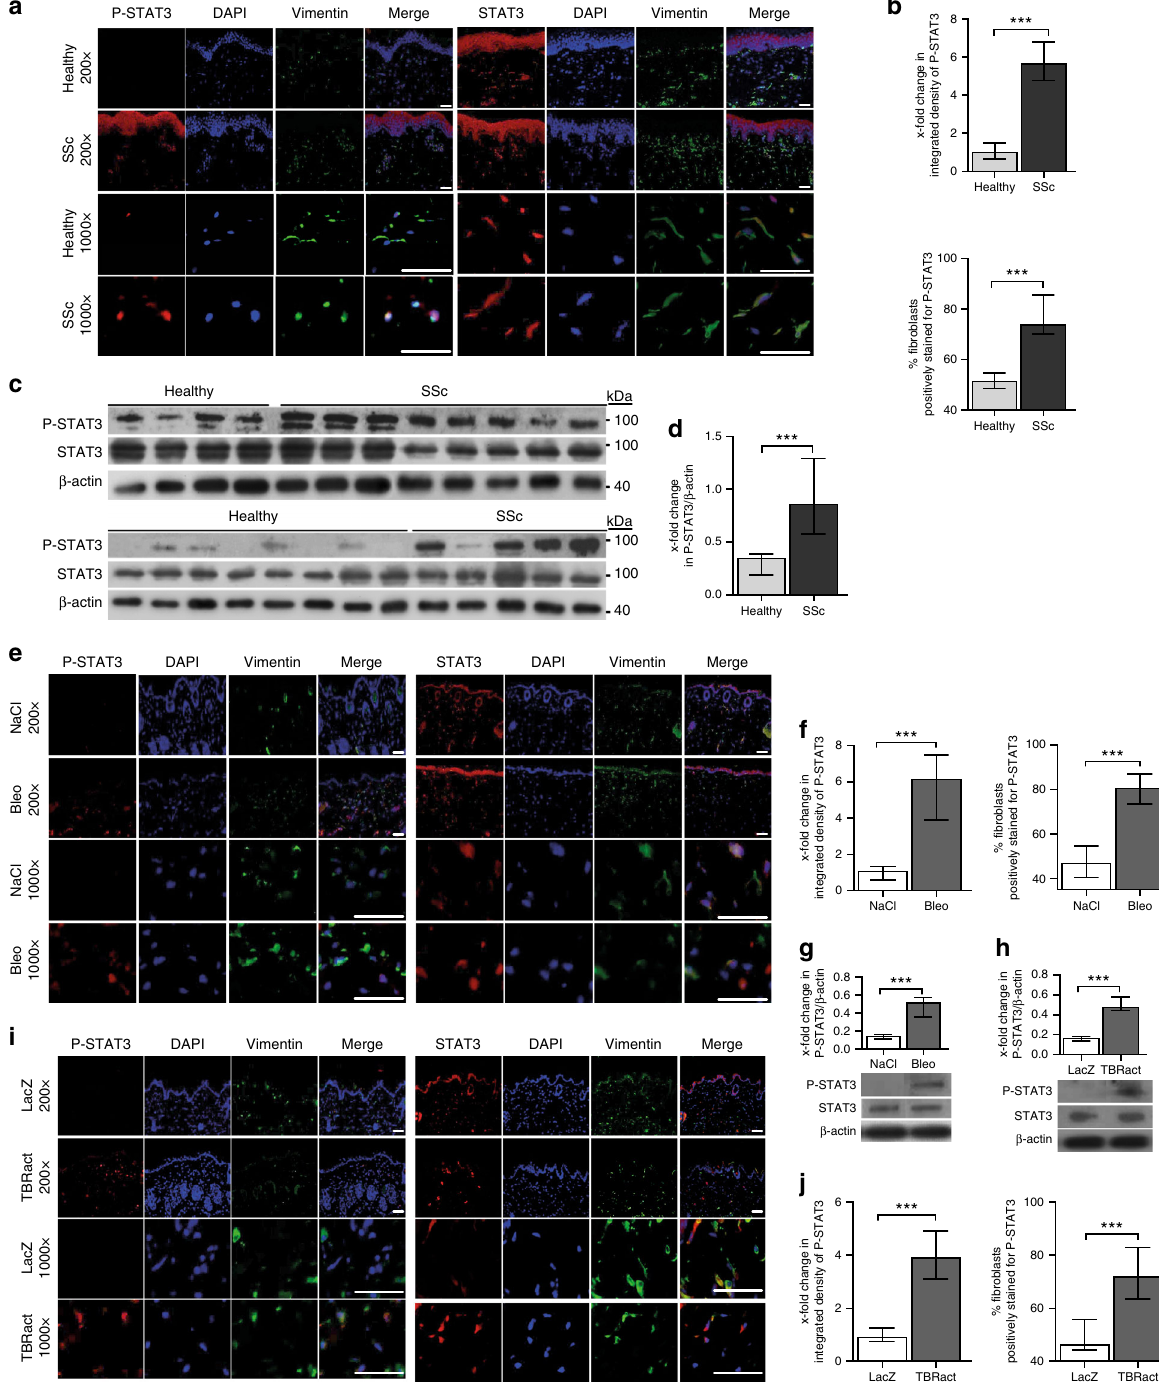
Fig. 1 Activation of STAT3 signaling in fi brotic SSc skin. a – d Evaluation of STAT3 signaling in human samples: a Representative images and b quantitative analysis of immuno fl uorescence staining for P-STAT3 (left) and total STAT3 (right) co-stained with the vimentin ( fi broblast marker) and DAPI (staining of nuclei) shown at 200-fold and 1000-fold magni fi cation ( n = 12 for SSc and n = 10 for healthy skin). c Western blots and d quanti fi cation of the levels of P-STAT3 and total STAT3 in human dermal fi broblasts from 13 SSc patients and 12 healthy individuals. e – g Evaluation of STAT3 signaling in the mouse model of bleomycin-induced skin fi brosis: e Representative images of immuno fl uorescence stainings (200-fold and 1000-fold magni fi cation) showing P-STAT3 (left) and total STAT3 (right) along with f quanti fi cation and g con fi rmation by western blot analyses in the skin of mice injected with NaCl or bleomycin ( n ≥ 6 for each group). h – j Evaluation of STAT3 signaling in the mouse model of TBRact-induced fi brosis: h Western blot and i , j immuno fl uorescence analyses of P-STAT3 expression in the skin of mice injected with TBRact. N ≥ 6 for each group with two or three technical replicates for all experiments. Expected band size for P-STAT3 and STAT3 are 79kDa (lower faint band) and 86kDa (higher intense band) and the ladder represents 100kDa. Beta-actin expected molecular weight/size is 42kDa. Horizontal scale bar, 100 μ m. Results are shown as median ± interquartile range (IQR). Signi fi cance was determined by Mann – Whitney test, as compared to healthy volunteers or with non- fi brotic control mice, respectively. * P < 0.05; ** P < 0.01, *** P <